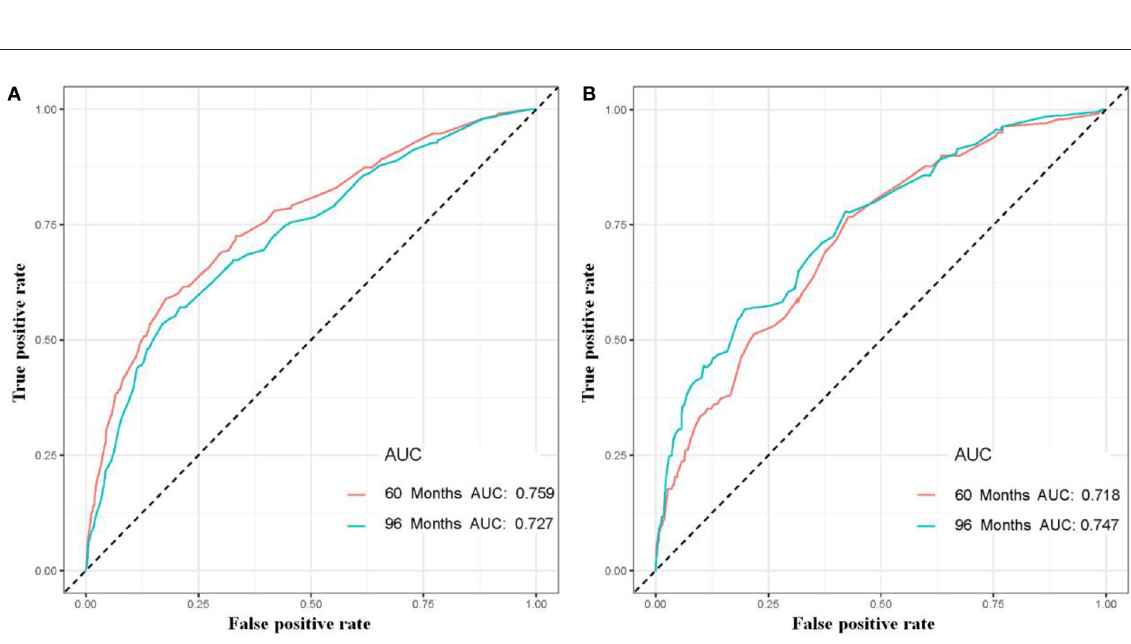
FrontiersinPublicHealth